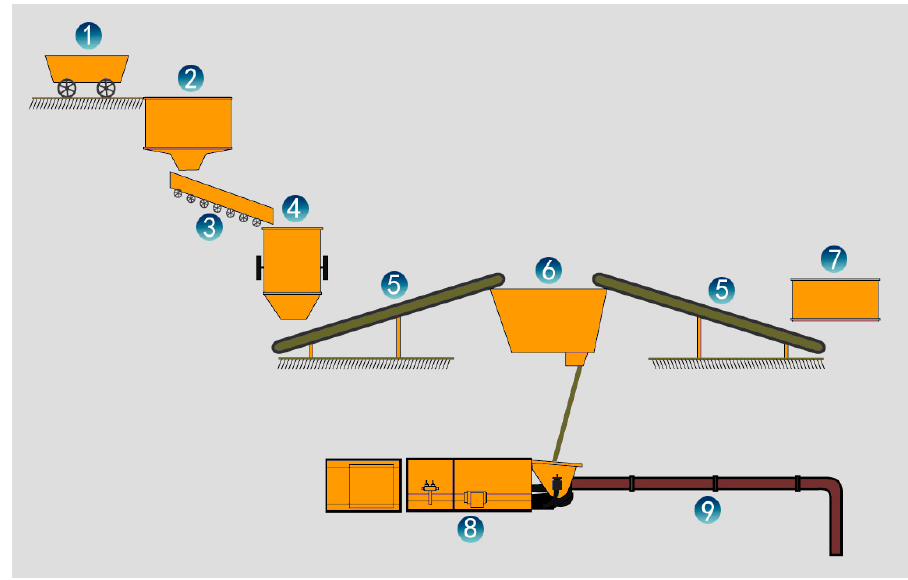
Figure 7. Sketch map of the space layout of the filling system. 1 : Gangue tramcar; 2 : Gangue bunker; 3 : Scraper conveyor; 4 : Gangue crusher; 5 : Conveyer belt; 6 : Filling material mixer; 7 : Fly ash storage bin; 8 : Filling pump; and 9 : Filling pipeline. Table 4. Filling equipment list.